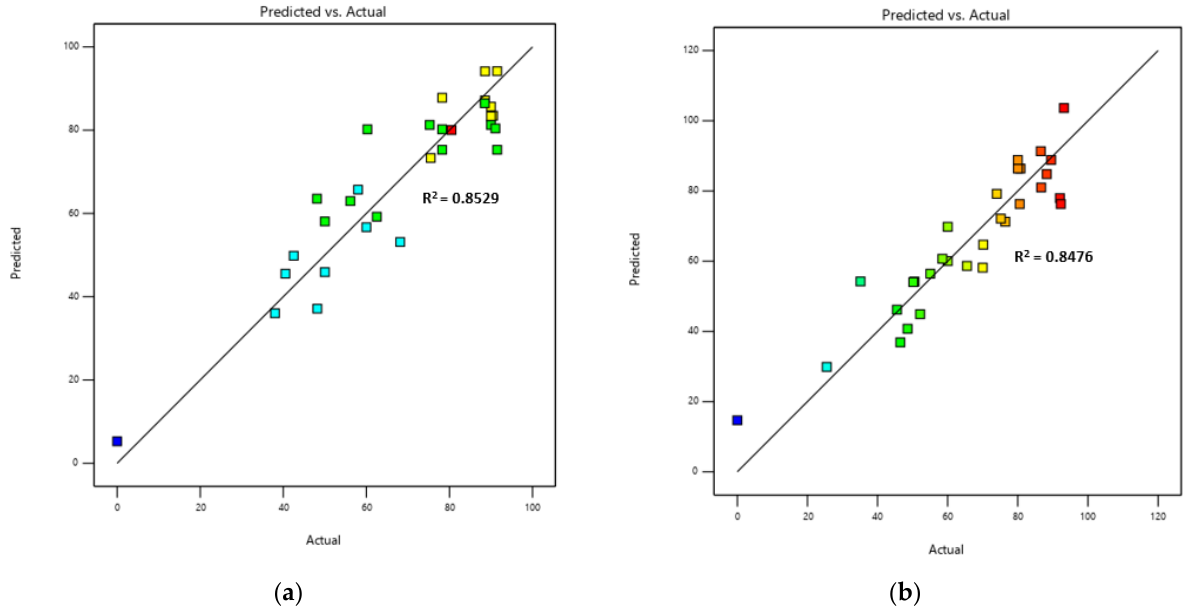
Figure 6. Plots of prediction against actual biodiesel yield: ( a ) CaO/CA; ( b ) NAOH/CA. 𝑌 = +78.92 − 5.88𝑋